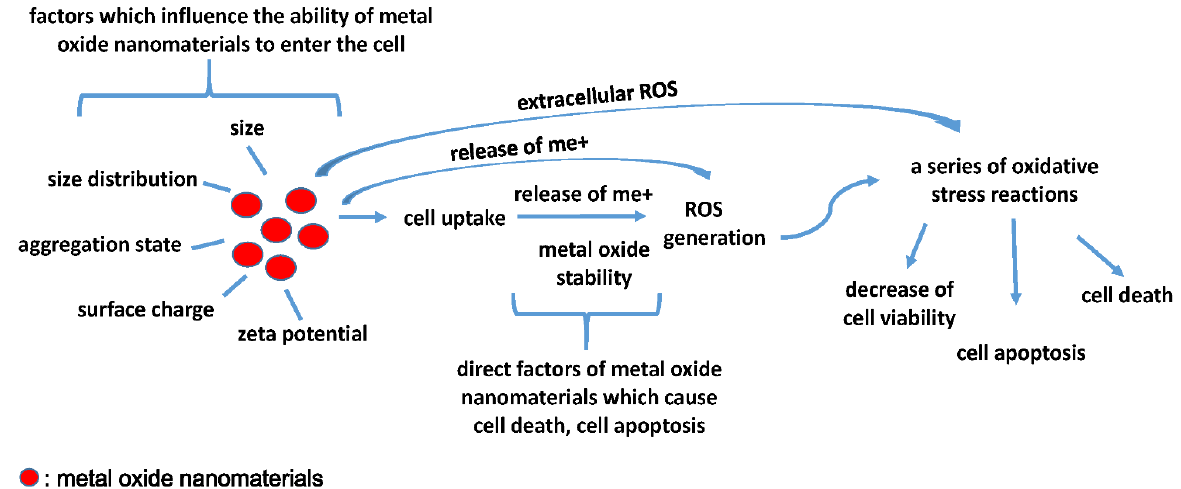
Figure 1. Characteristics such as size, size distribution, aggregation state, surface charge, and zeta potential can affect the cellular uptake of metal oxide nanomaterials. After entering the cell, metal oxide stability is an important factor that causes toxic effects, such as ions detaching from the surface of metal oxide nanomaterials, inducing ROS generation and then causing a series of oxidative stress reactions related to cell viability, cell apoptosis and cell death. In addition, extracellular ROS and released ions can also induce a series of oxidative stress